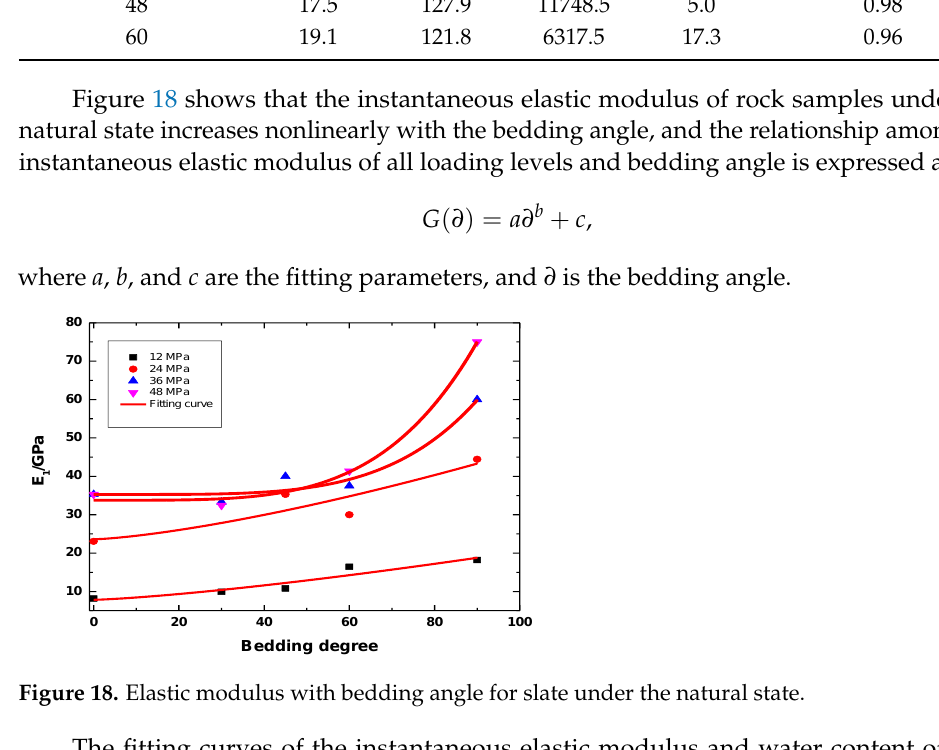
Figure 18. Elastic modulus with bedding angle for slate under the natural state. The fitting curves of the instantaneous elastic modulus and water content of rock samples with a bedding angle of 0 ◦ in different water bearing states are shown in Figure 19. The instantaneous elastic modulus decreases linearly with the increase in water content under different stress levels. The instantaneous elastic modulus and water content are expressed as follows: where d and e are the fitting parameters, and w is the moisture content.